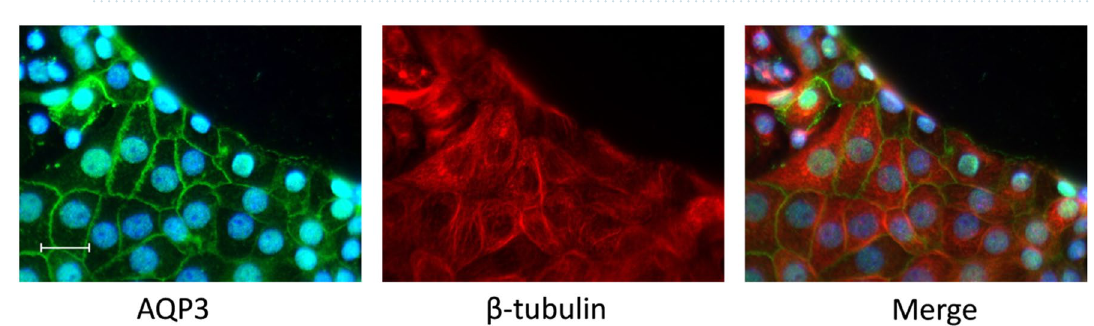
Figure 7. Intracellular accumulation of AQP3 after bafilomycin treatment. Wound healing assays were performed with IMCD-cells cultivated at 600 mosmol/kg. A wound was induced and the cells were treated with V-ATPase activity inhibitor bafilomycin (100 nM) or the proteasomal activity inhibitor MG132 (2 µM). After 4 h the cells were stained for AQP3 using specific antibodies. Alexa-488 labeled secondary antibodies were used for visualization. The nuclei were stained with DAPI. Scale bar = 20 µm, representative image chosen from 2 independent experiments.